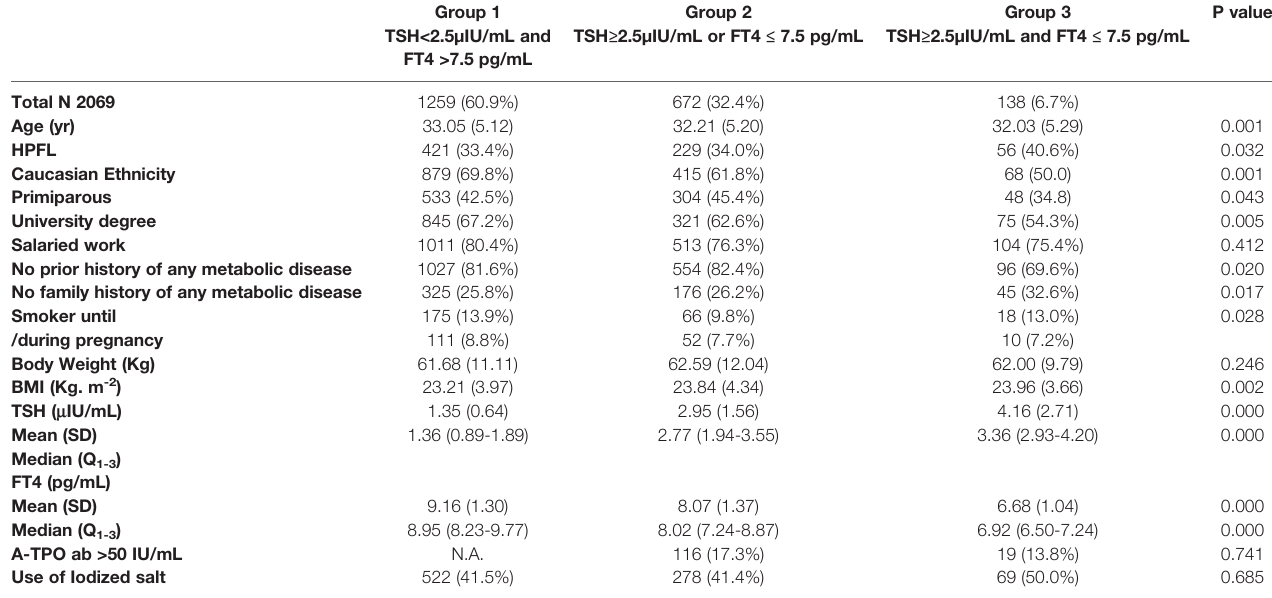
TABLE 3 | Characteristics of the women studied in Study 2 .